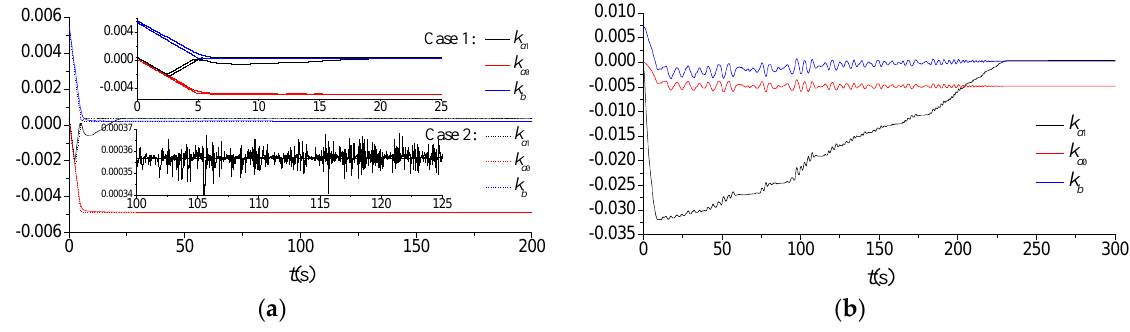
` ˘ 1. a m e ` a m 0 e ; ( b ) Adjustable parameters